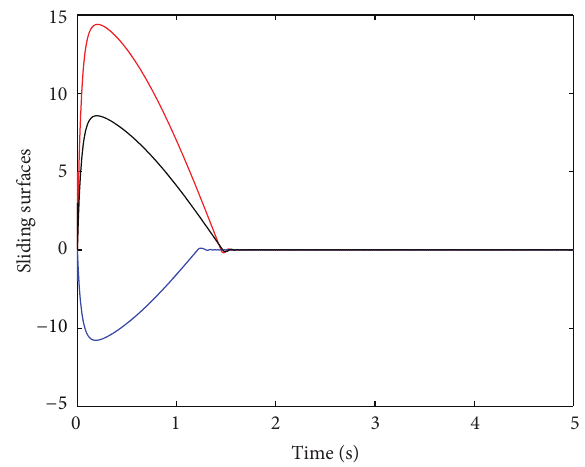
Figure 11: Sliding surfaces states in the presence of systematic uncertainties and external disturbances with 𝛼 = 0.5 (red line represents the first sliding surface state 𝑠 1 , blue line represents the second sliding surface state 𝑠 2 , and black line represents the third sliding surface state 𝑠 3 ).